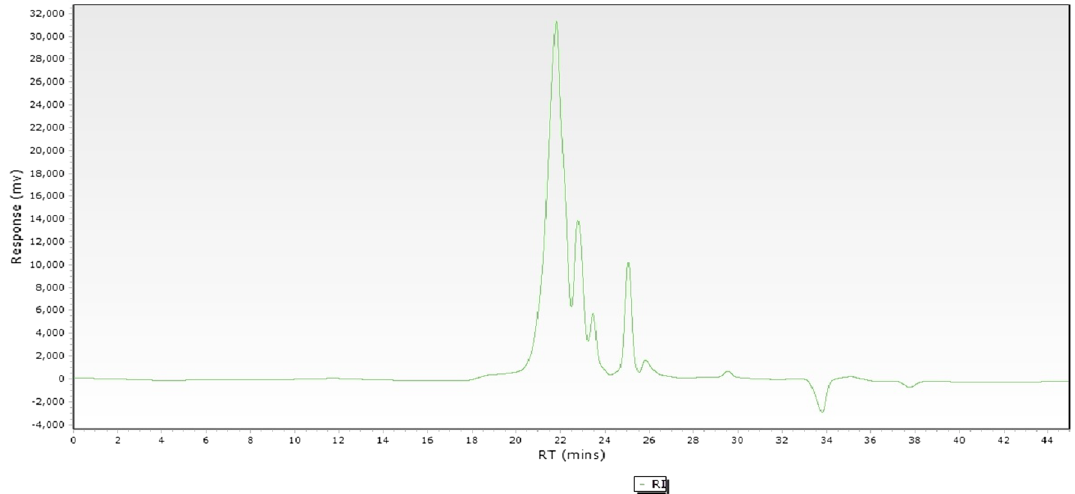
Fig. 4 GPC plot of MA-SMADS